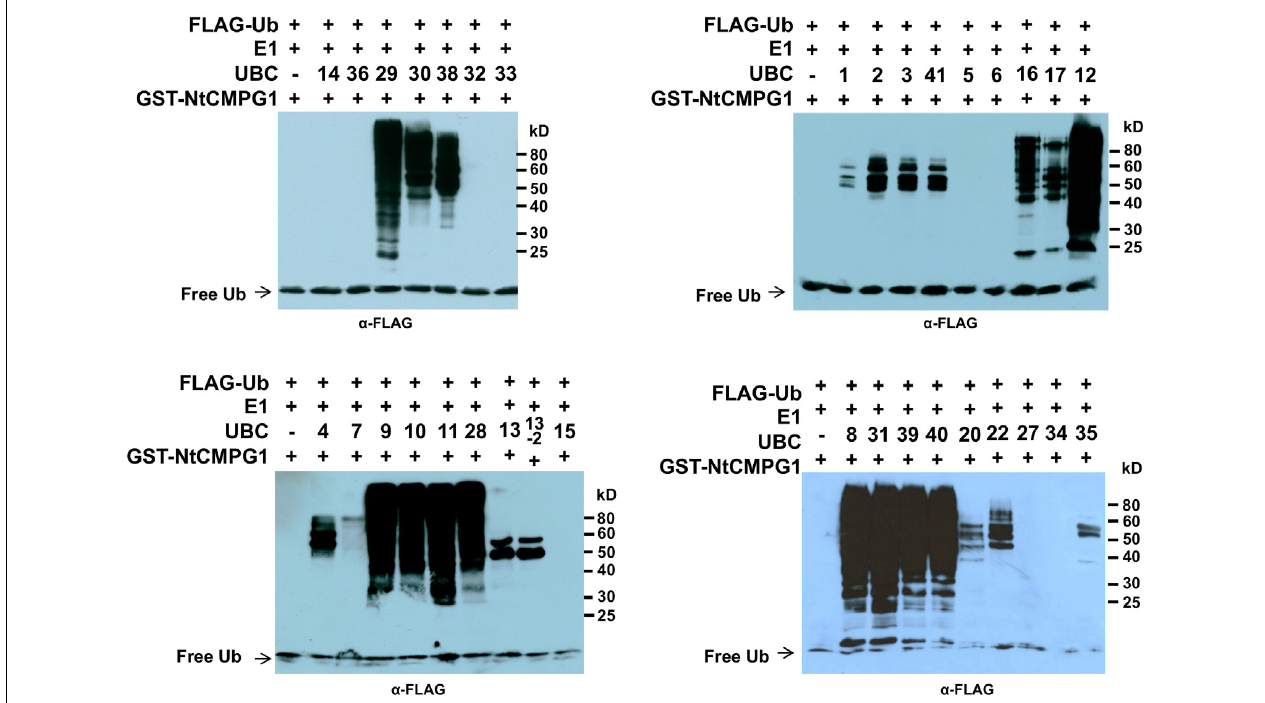
FIGURE 7 | NtCMPG1 works specifically with group III E2s in vitro . GST-NtCMPG1 was tested with 34 purified tomato E2 proteins (Zhou et al., 2017) in in vitro ubiquitination assay to determine its specificity of toward ubiquitin E2s. Tomato E2 protein used in each reaction is shown above the lane by their UBC number and the minus marker (–) denotes the absence of any E2 enzyme in the reaction. The presence of high MW smear of ubiquitinated proteins as detected by Western blot using anti-FLAG antibody indicates E2-E3 specificity. The numbers on the right denote the molecular mass of marker proteins in